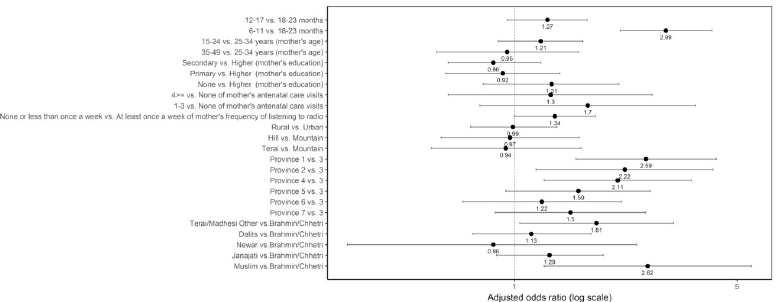
Fig 14. Odds ratio plot with 95% confidence intervals for not consuming vitamin-A rich fruits and vegetables among Nepalese children aged 6 to 23 months.